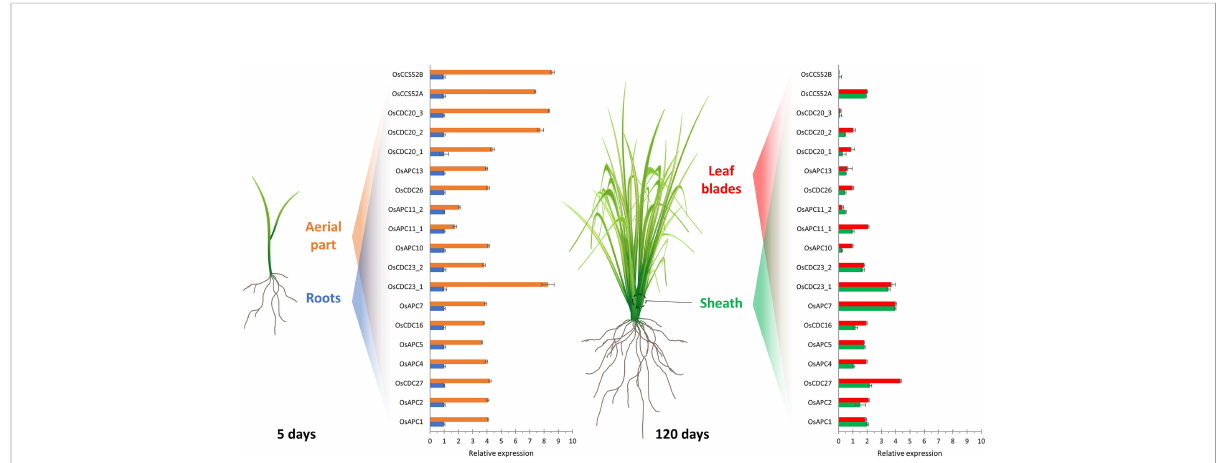
FIGURE 2 Relative expression pro fi le of rice APC/C subunits and activators in different tissues. Expression analysis of genes from the APC/C subunits and activators in shoots and roots (5-day old seedlings) and in leaf sheath and blade (120-day old plants) of rice. Expression levels are normalized to root. Adapted from Lima et al.,